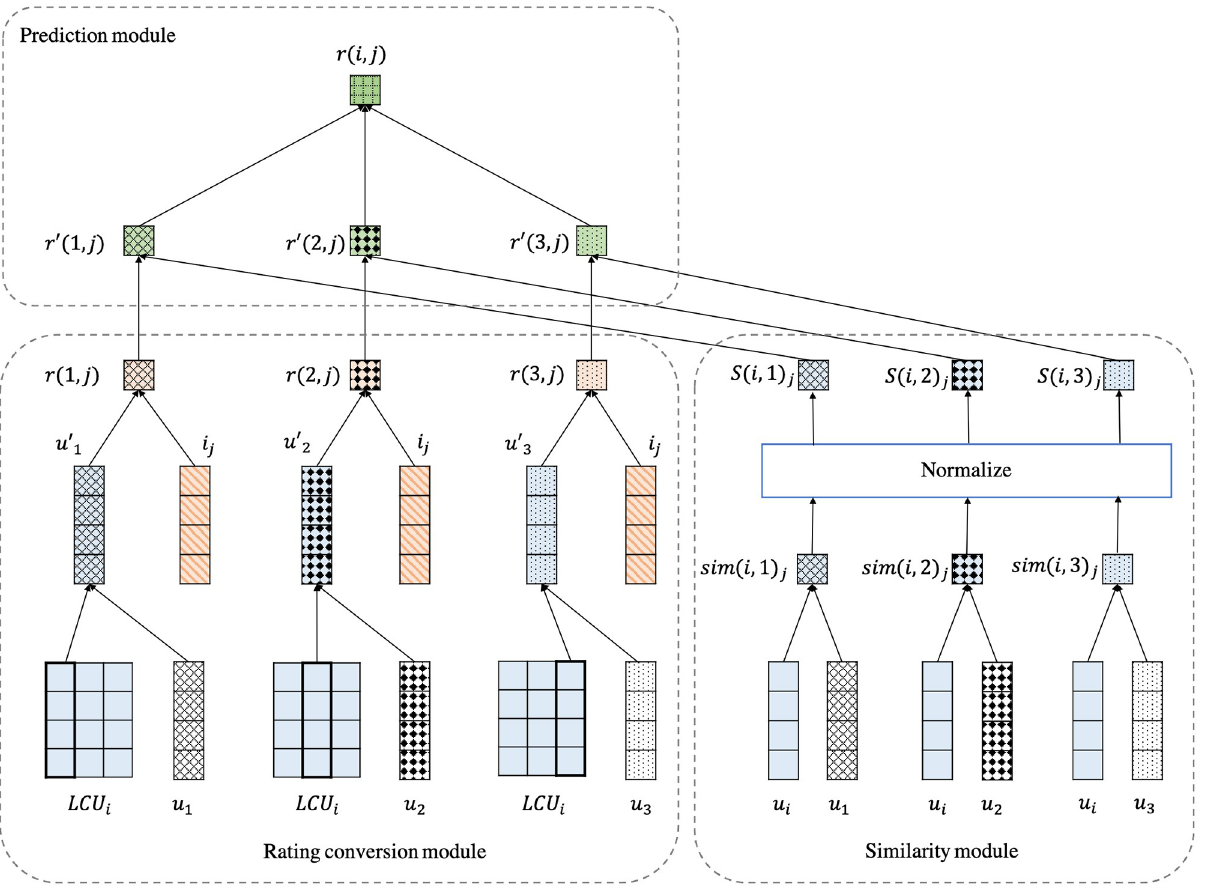
Fig 5. The proposed model